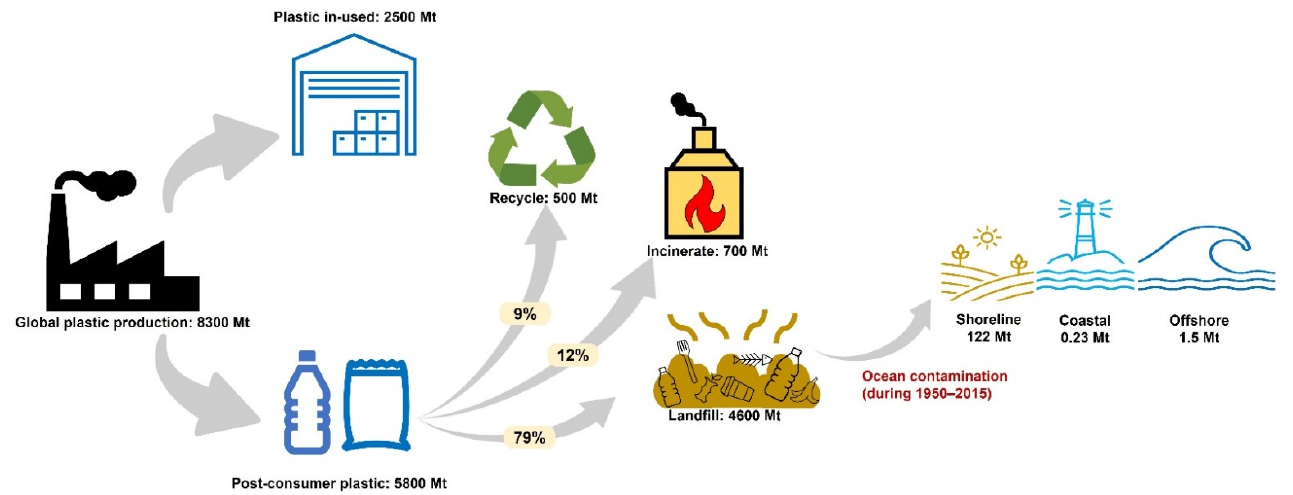
Figure 3. The pathway of plastics from primary production until end-of-life, during the period 1950– 2015, based on the study of Geyer et al. (2017) [9] and Lebreton et al. (2019) [10].